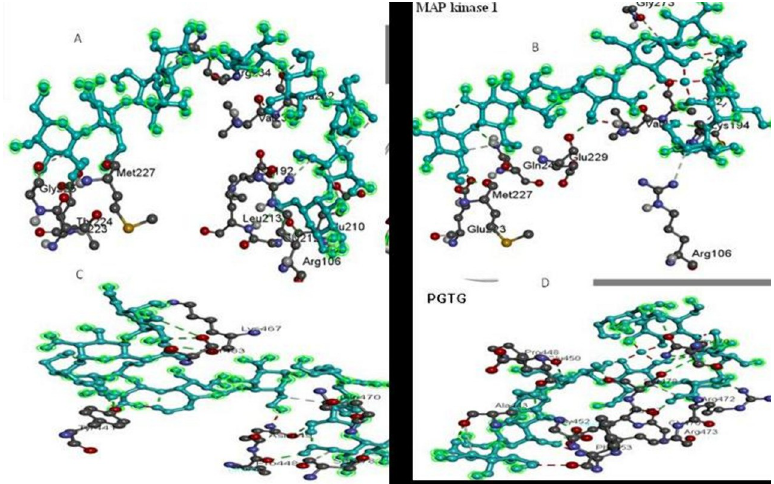
Fig 9. The overall 3D surface view of the modeled protein. PtMAPK1 and PGTG with chitosan only and chitosan– Cu complex. MAPK1 with chitosan only, (B) MAPK1 with chitosan–Cu complex, (C) PGTG with chitosan only and, (D (PGTG with chitosan–Cu